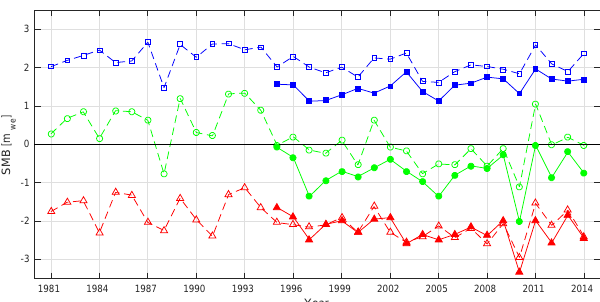
Figure 10. Average summer (red lines), winter (blue lines), and net (green lines) specific surface mass balance for the whole of Vatna- jökull. The solid lines are the mass balance of Vatnajökull based on mass balance measurements and manual interpolation, while the dashed lines are the mass balance as simulated by HIRHAM5.